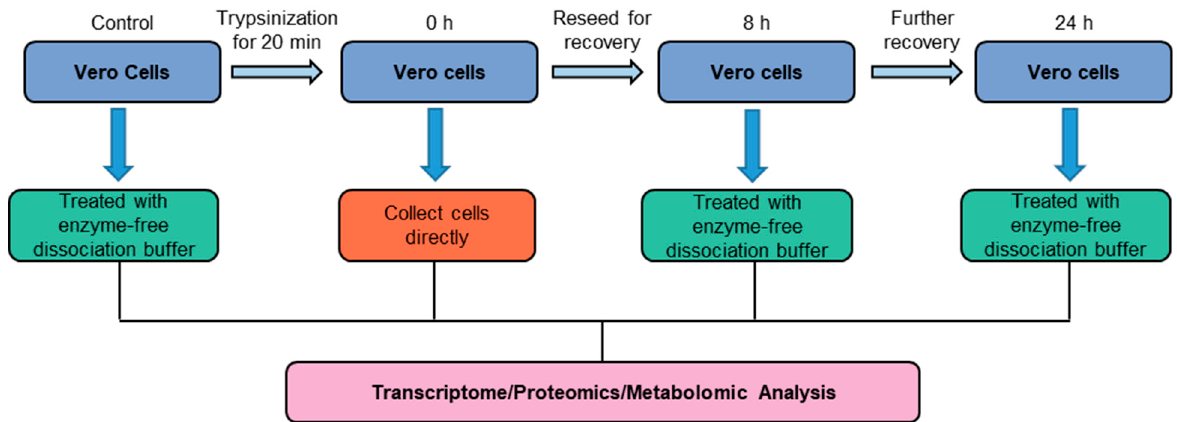
Figure 1. Overview of the workflow of the cell detachment